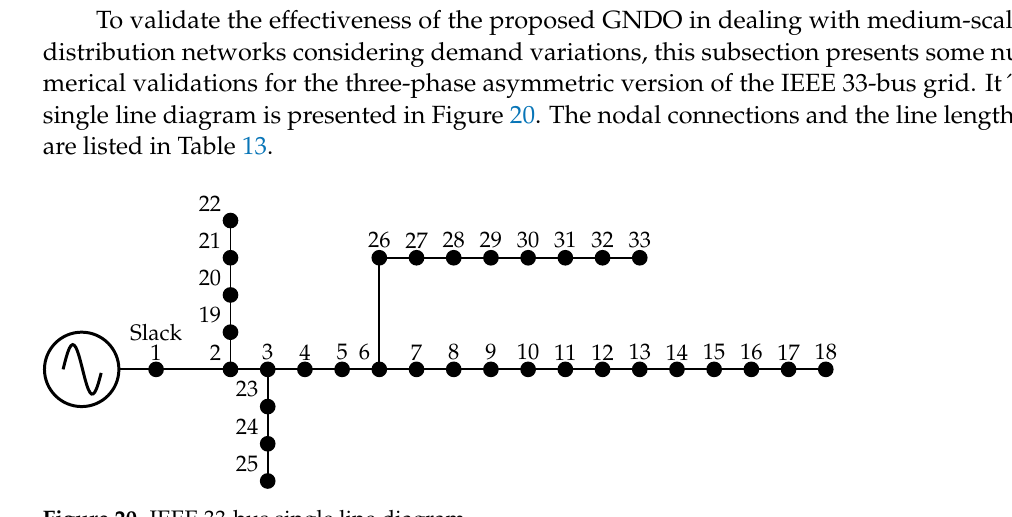
Figure 20. IEEE 33-bus single line diagram. Table 13. Information corresponding to the 33-bus test